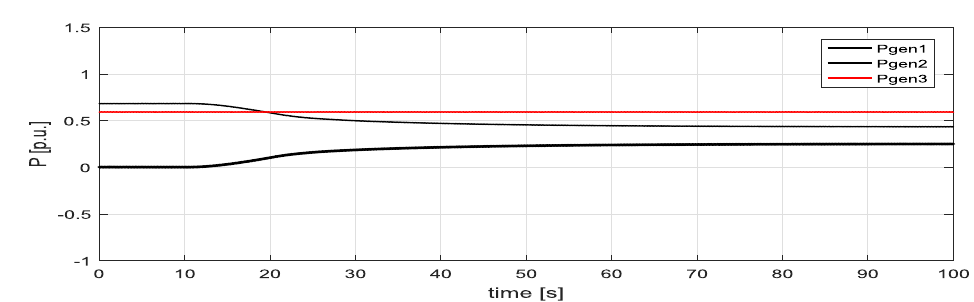
Figure 17. Time evolution of active powers (Pgen) of the three generators.